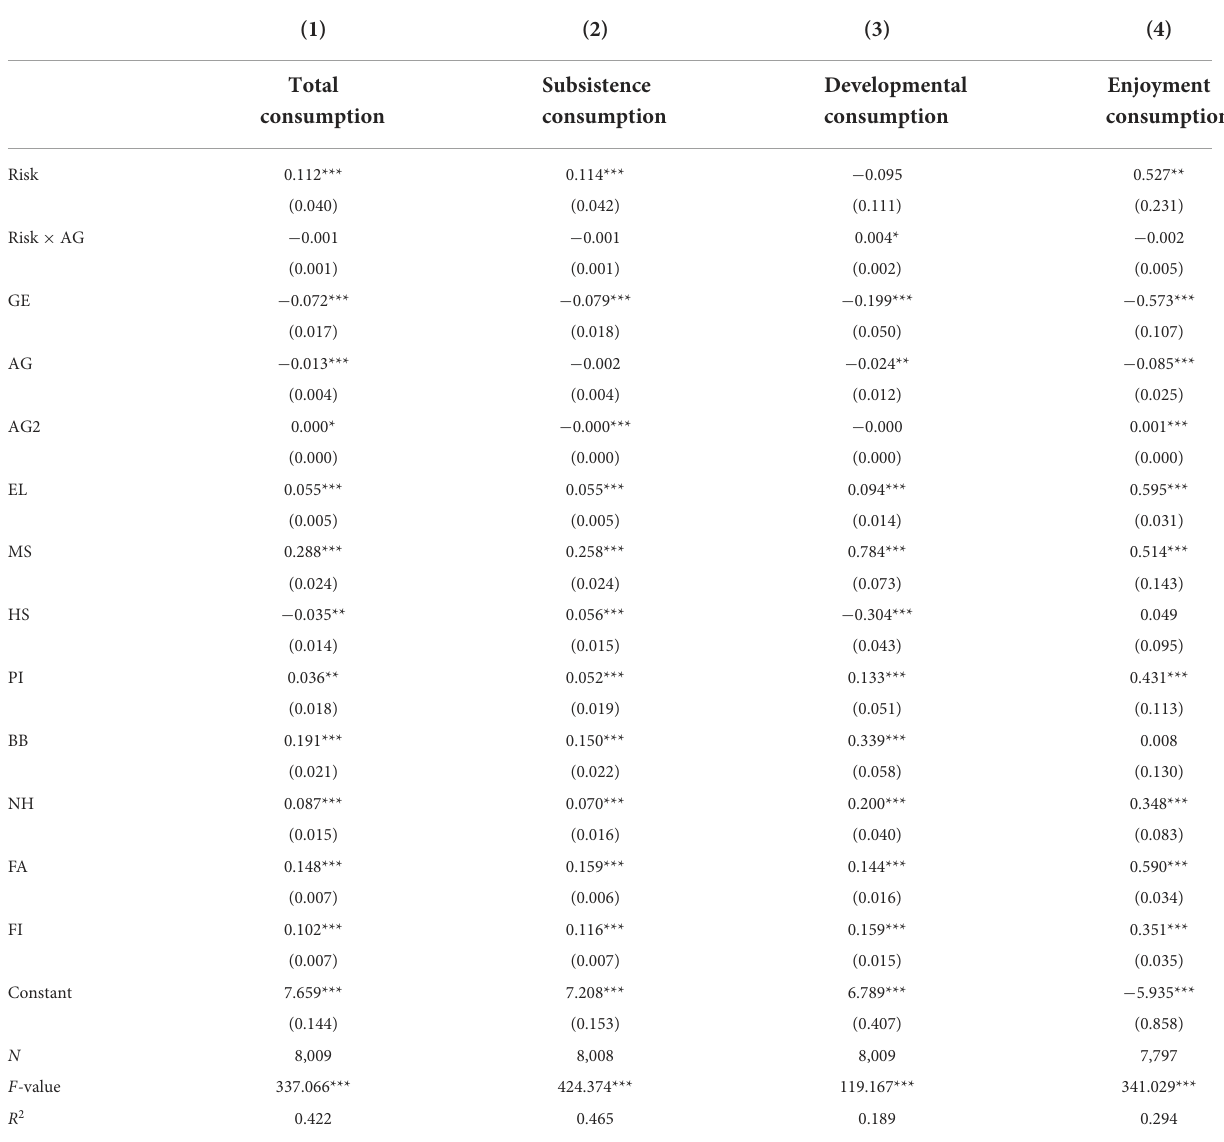
TABLE 8 Results of age heterogeneity